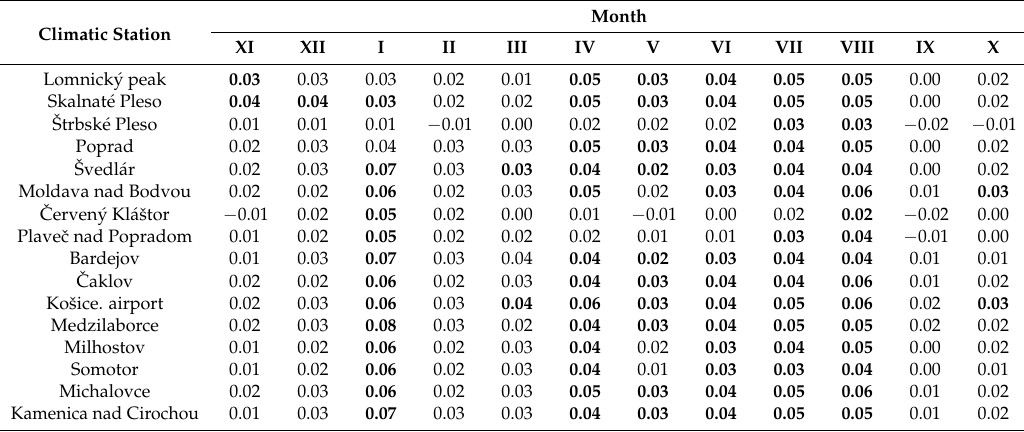
Table 5. Monthly temperature trends in climatic